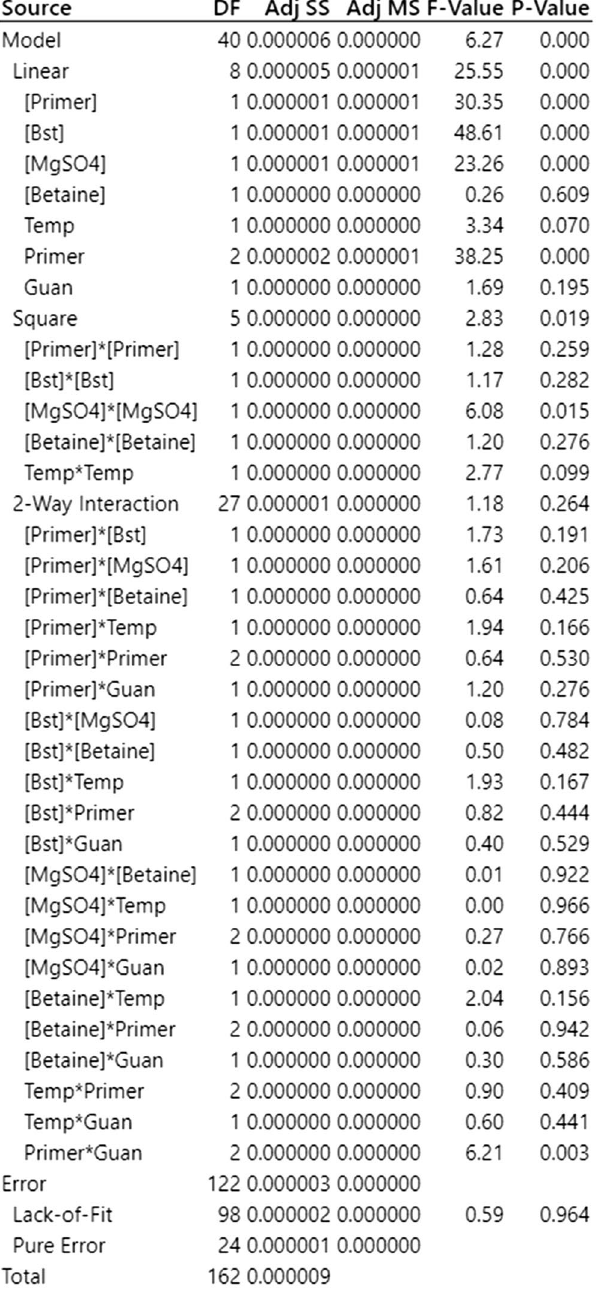
Figure 2. ANOVA of the TTR response obtained from the software Minitab with the tested factors and the respective P -value. The factors such as primer concentration ([Primer]), Bst concentration ([ Bst ]), magnesium sulfate concentration ([MgSO4]), and primer sequence (Primer) were statistically significant, p <